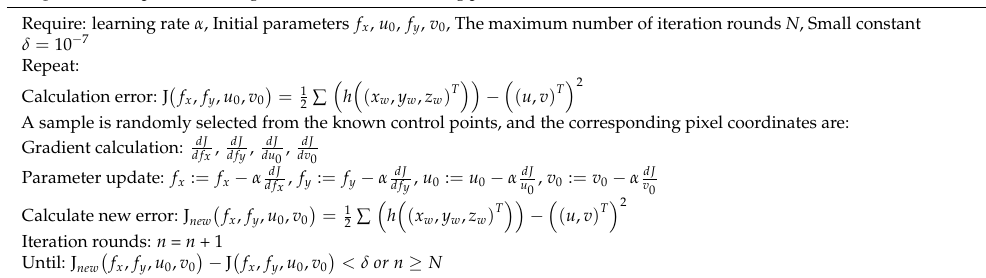
Algorithm 1. Optimization algorithm based on vanishing point